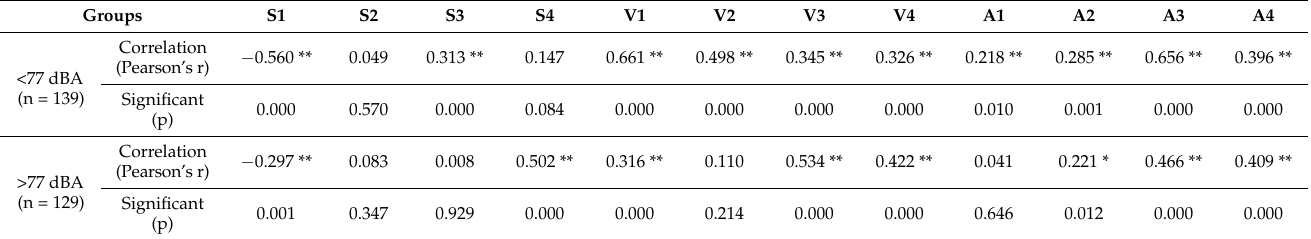
Table 5. Correlational analysis between the overall soundscape comfort and other